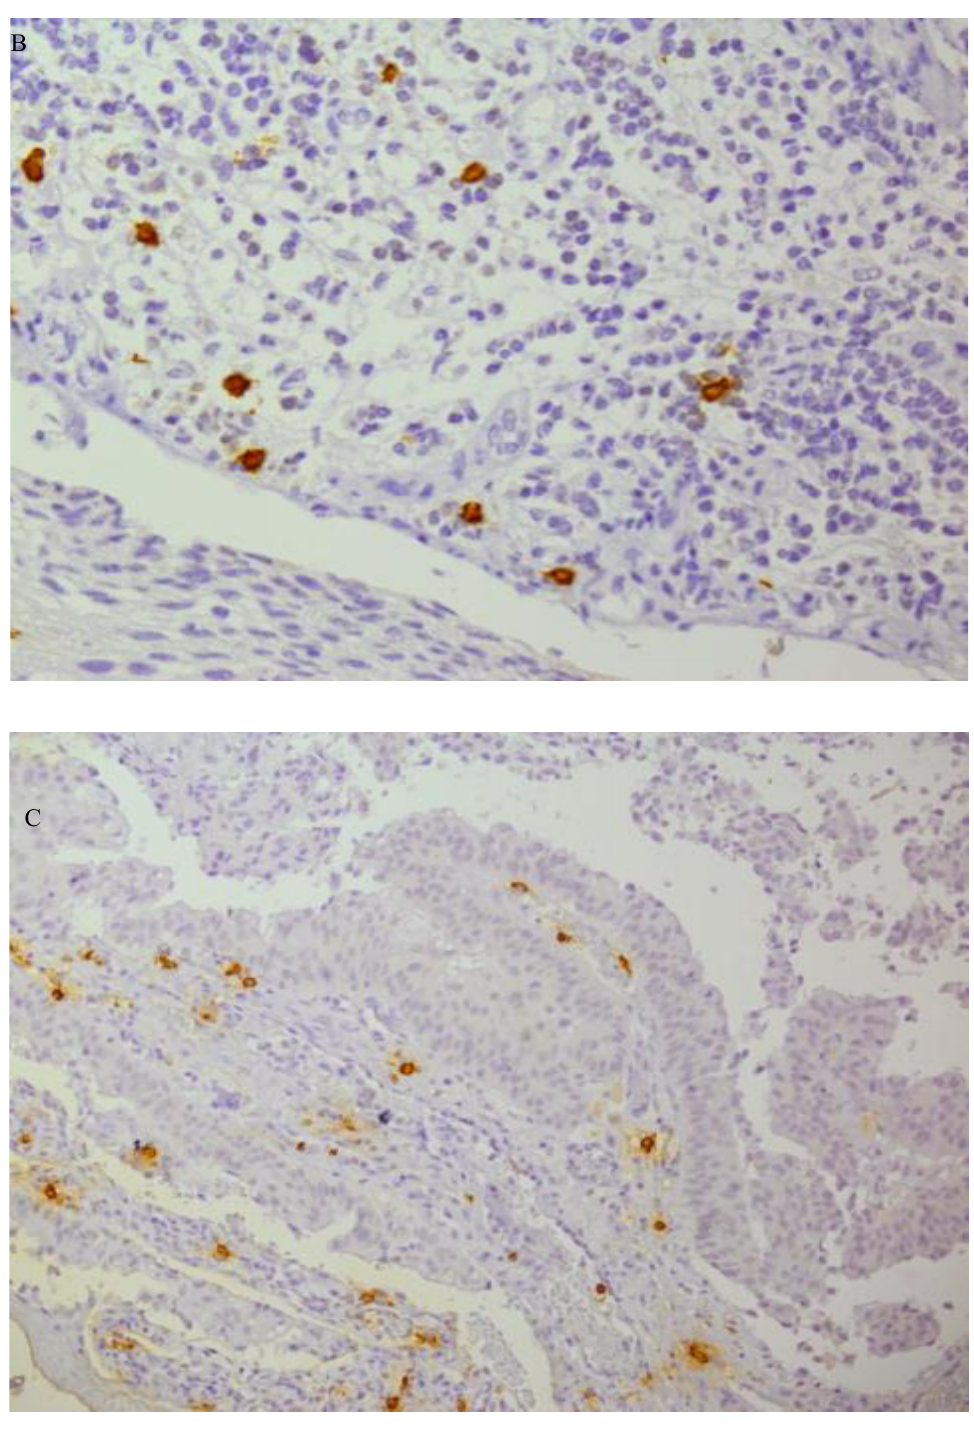
Fig. 2 . A, B, and C: (X10- X20- X40 magnification, respectively) High-grade TCC stained by mast cell tryptase, highlighting mast